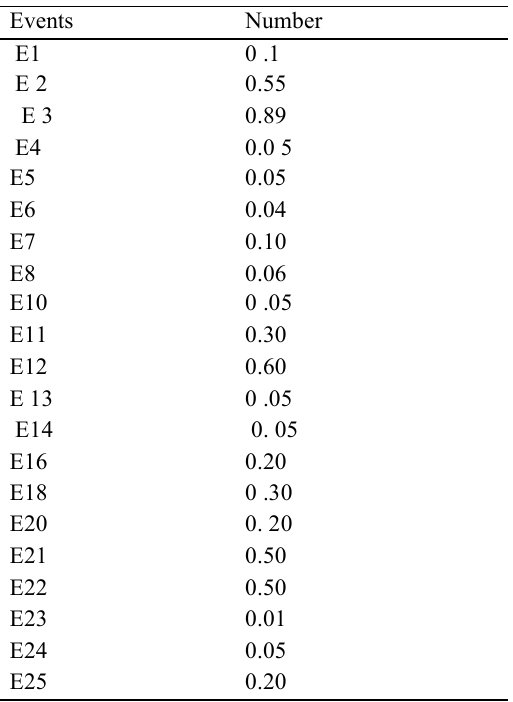
The probability of occurrence of basic